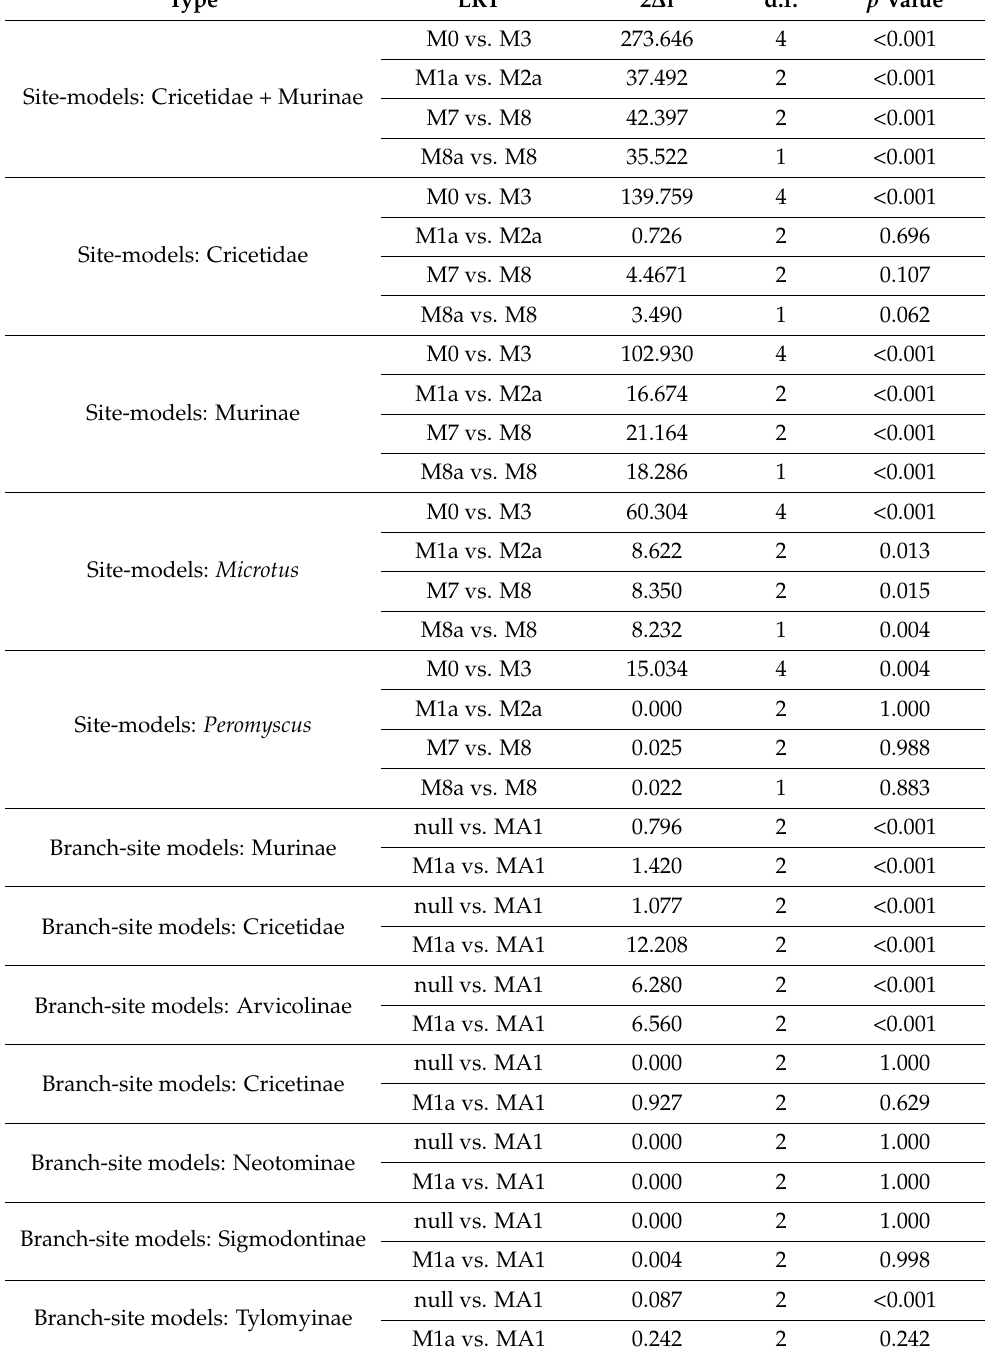
Table 1. Results of the likelihood ratio tests (LRT) considering site- and branch-site models imple- mented by PAML on exon 6 and 7 of the ZP3 gene of the